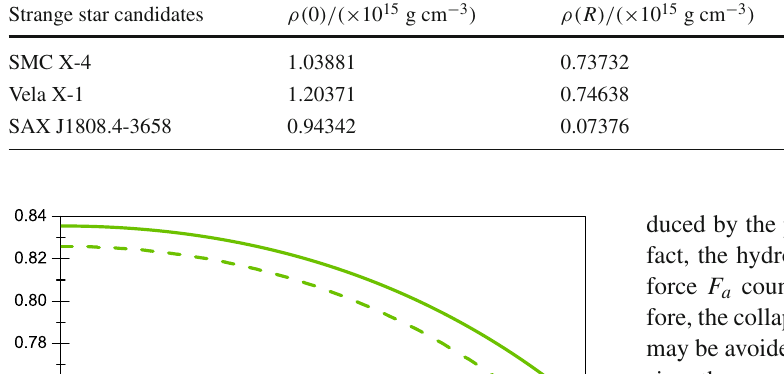
Table 2 Some physical parameters calculated for radii and mass for some strange star candidates with α = 0 . 3 Strange star candidates